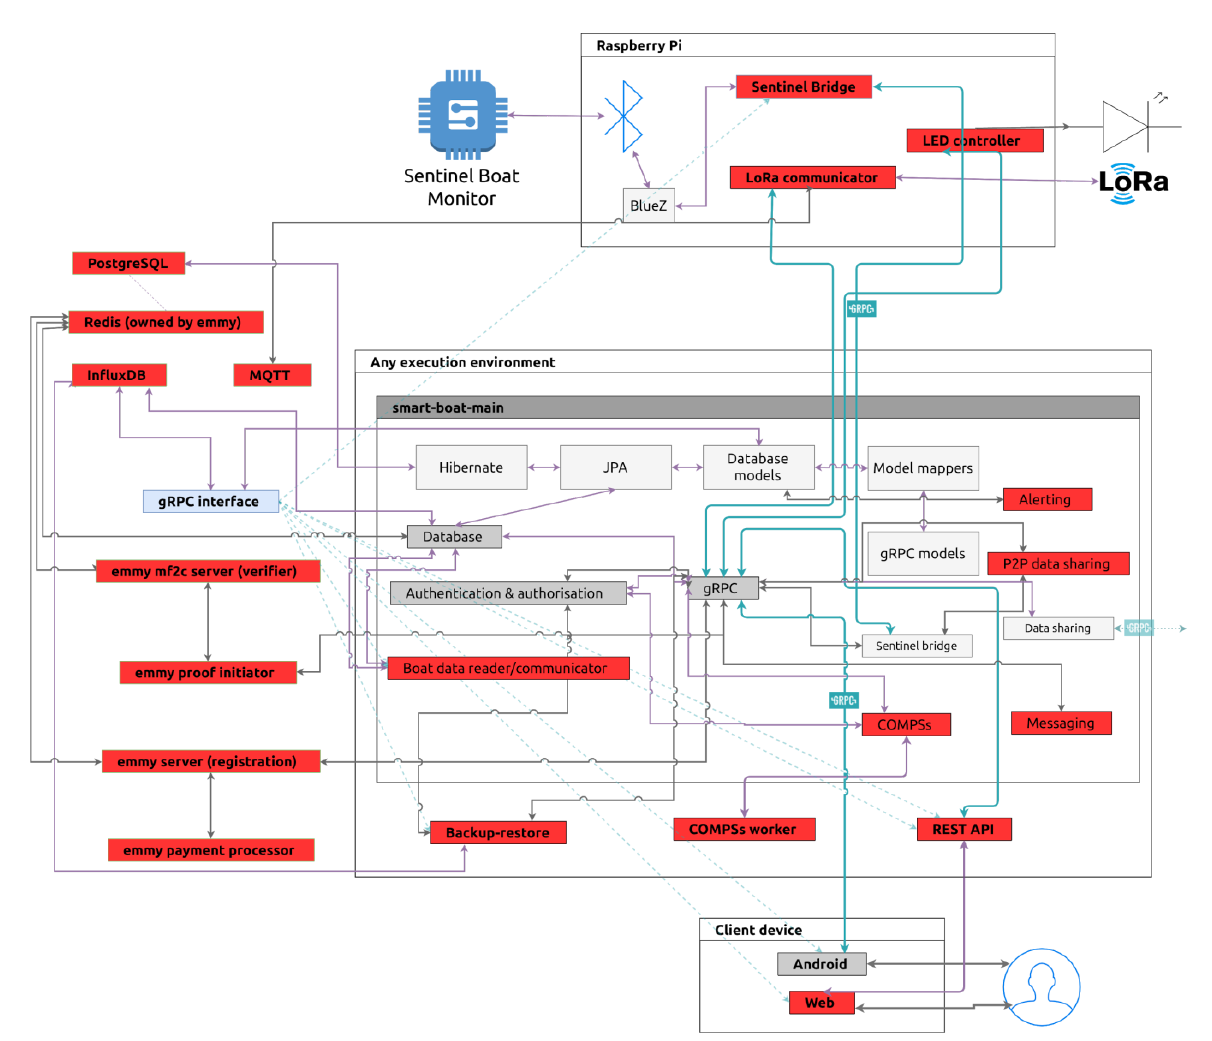
Figure 3. mF2C deployed at the SBS use case: Simplified diagram of the SBS architecture. Table 3. KPIs summary for the SBS use case.